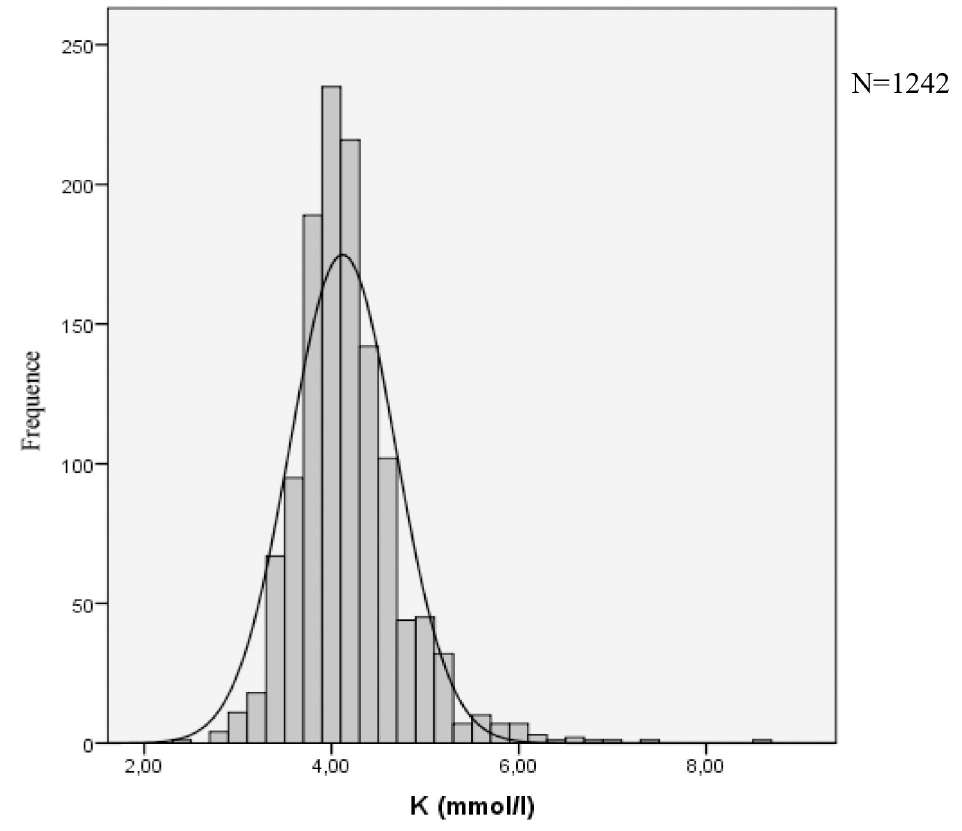
Fig 2. Potassium distribution.